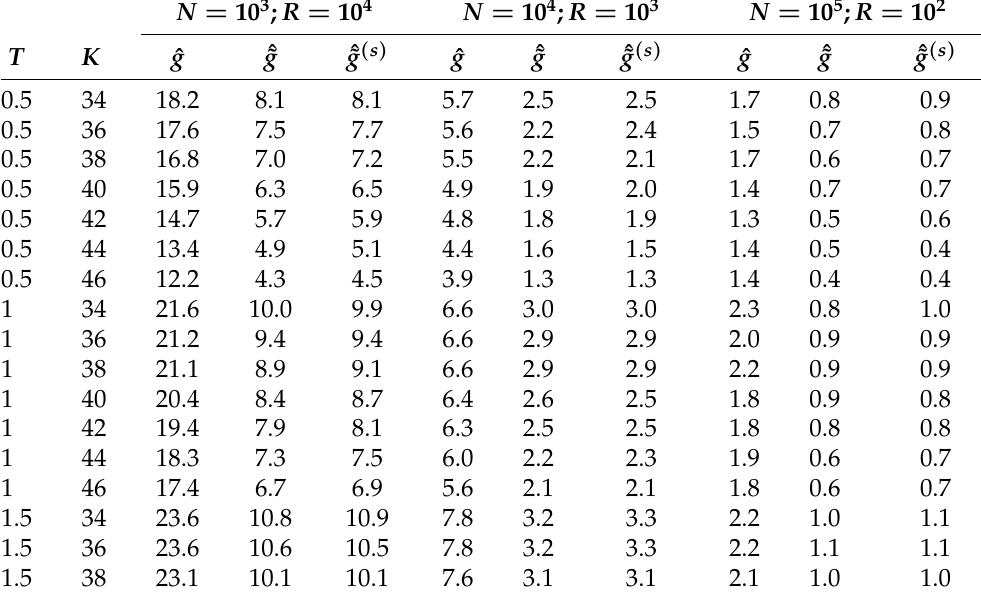
Table A3. Detailed standard deviation results ( × 10 2 ) with optimized